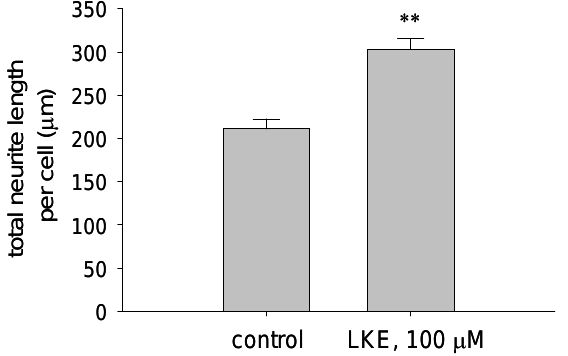
Figure 2. LK-5-ethyl ester (LKE) promotes neurite extension in primary, dissociated chick dorsal root ganglia (DRG) cultures. Neurons were treated with LKE or saline vehicle for 24h and quantitatively assessed for neurite morphometry as described in the text.